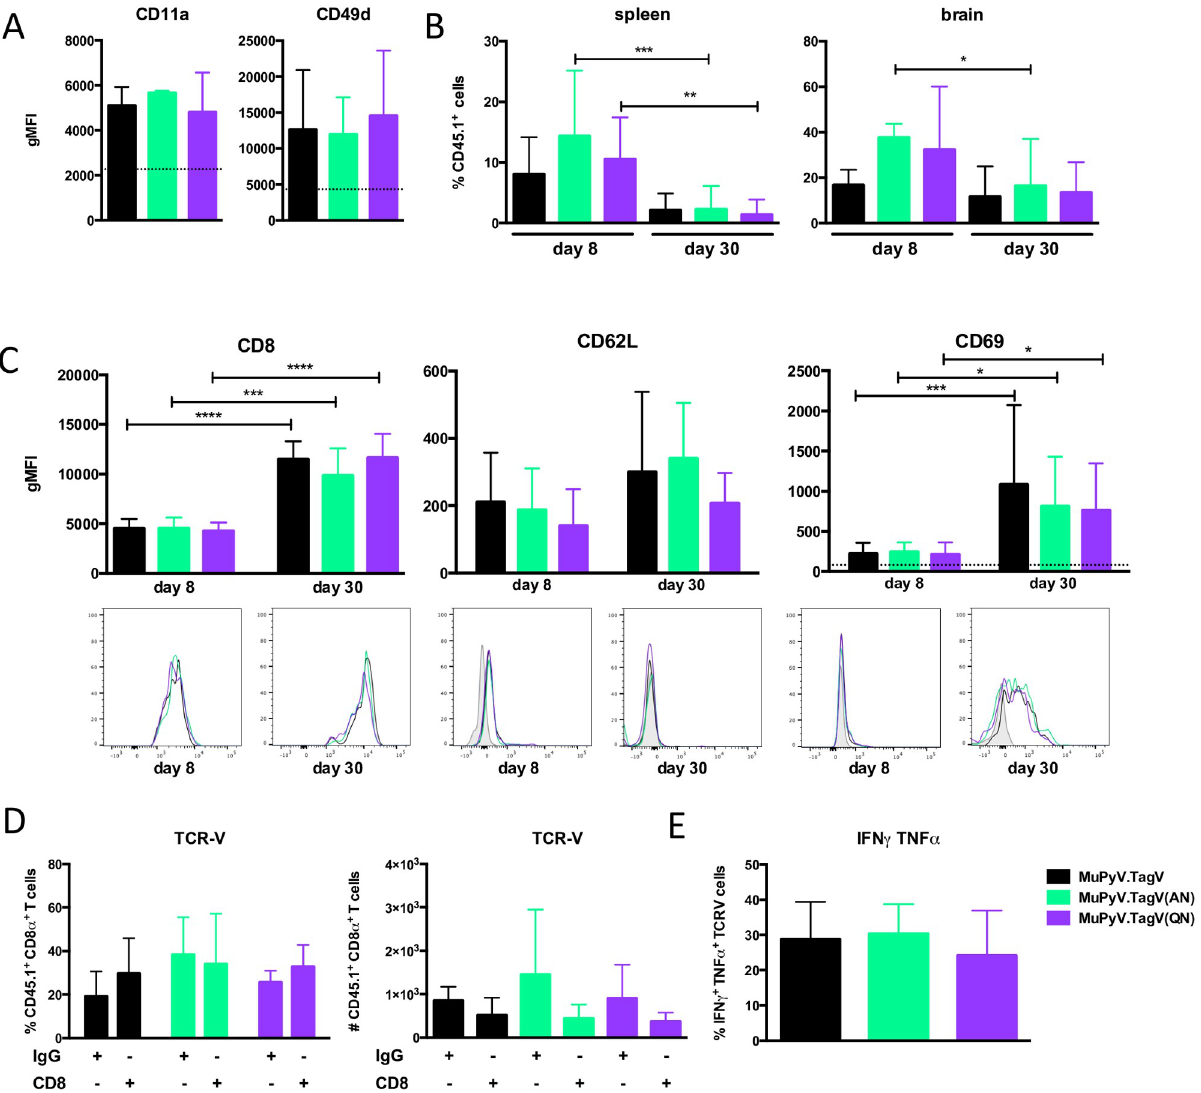
Fig 5. Systemicinfection with TagV analogue MuPyVs recruits anti-PyV CD8 T cells to the brain. (A) CirculatingTCR-V cells at day 8 p.i. show increasedexpressionof adhesionmarkers CD11aand CD49d. Dashedline indicatesbaselineexpressionon na ï veTCR-V cells. (B) Percentage of TCR-V cells in the spleen (left panel)and brain (right panel)at days 8 and 30 p.i. (C) gMFI of CD8, CD62L, and CD69 expressionon TCR-V cells in the brain at days 8 and 30 p.i. Representative histograms shown. Gray shadedhistogram refers to fluorescence-minus-one control. (D) Percentage (right panel)and number(left panel)of TCR-V cells in the brains of mice given systemic anti-CD8 α or control rat IgG. (E) IFN γ and TNF α co-expression in brain-resident TCR-V cells stimulated for 5 h ex vivo with 1 μ M TagV peptide. Mean ± SD plotted. N = 9–15 mice from 3–5 independentexperiments. * , p < 0.05; ** , p, 0.005; *** , p < 0.0005; ANOVA with Tukey’s test for significance.